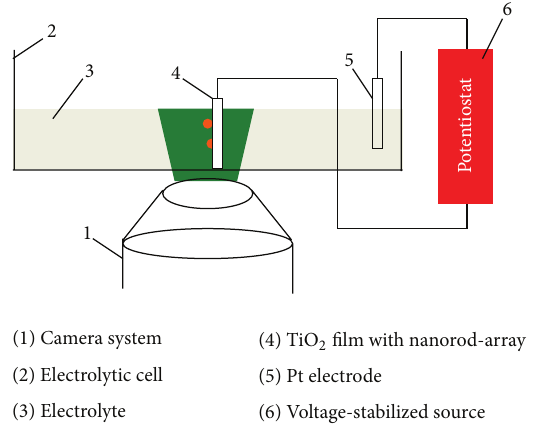
Figure 2: Schematic of the experiment setup.